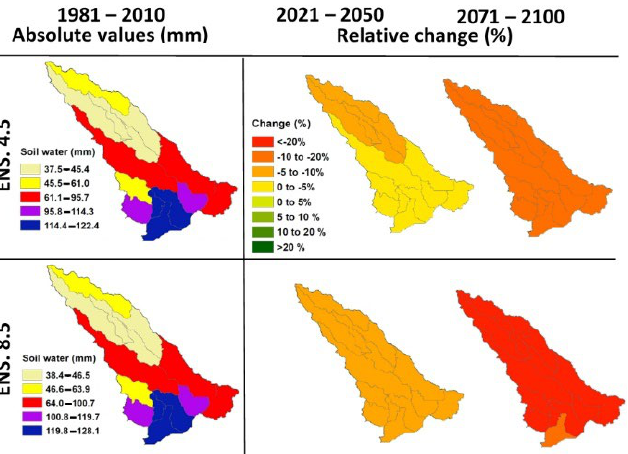
Figure 7. Catchment-scale distribution of growing season average soil water content (SW) for the reference period (mm) and the relative change compared to the reference period (%) for each RCP.